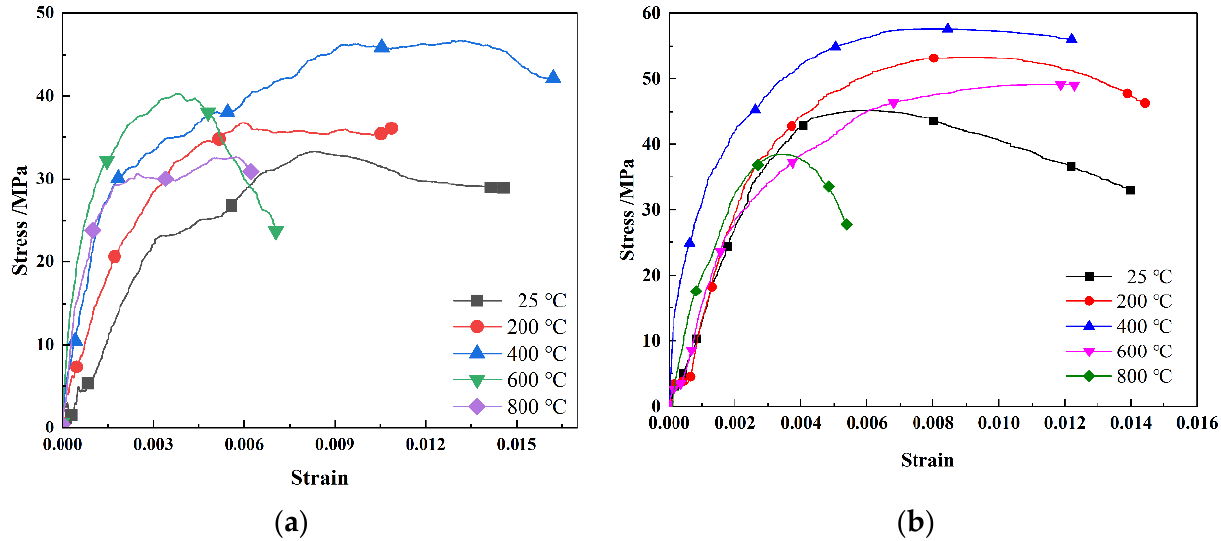
Figure 8. Dynamic stress–strain curve for a confining pressure of 0.5 MPa. ( a ) Impact velocity = 5.3 m/s; ( b ) impact velocity = 8.6 m/s.